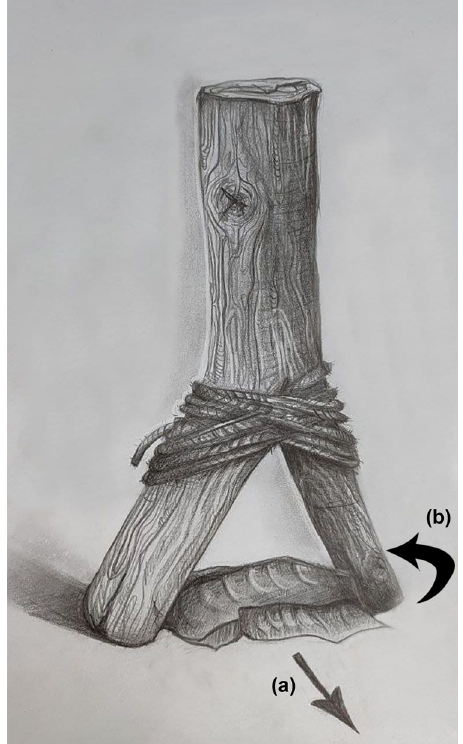
Figure 12: A hypothetical reconstruction of the way Kukrek inserts were hafted. ( a ) Direction of force application; ( b ) rotation movement resulting in characteristic macroimpact fractures. Concept: S. Radchenko, Drawing: D.